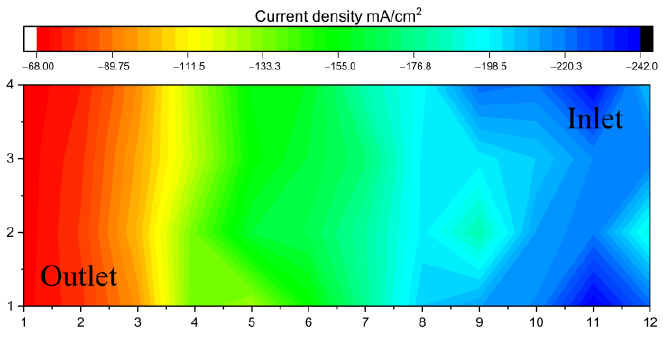
Figure 5. Current density distribution at limiting conditions for V H2 = 65 mL min − 1 with reversed Figure 5 . Current density distribution at limiting conditions for V H2 = 65 mL min — 1 with reversed electrolyte direction (from right to electrolyte direction (from right to left).